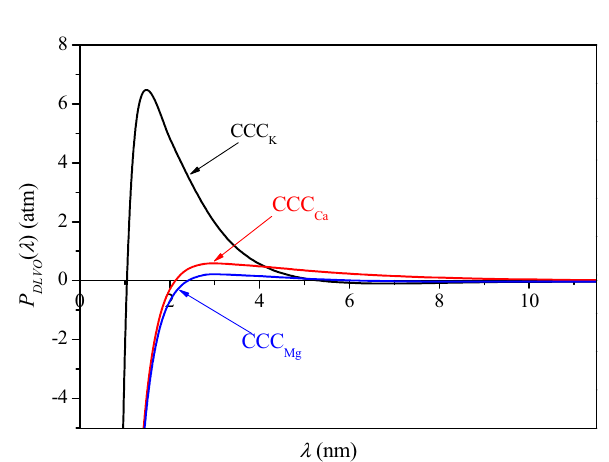
Figure 8. The zeta potential of BSC aggregates in different concentrations of K + , Mg 2+ and Ca 2+ electrolytes. Data are expressed as the mean ± standard deviation of triplicate measurements.